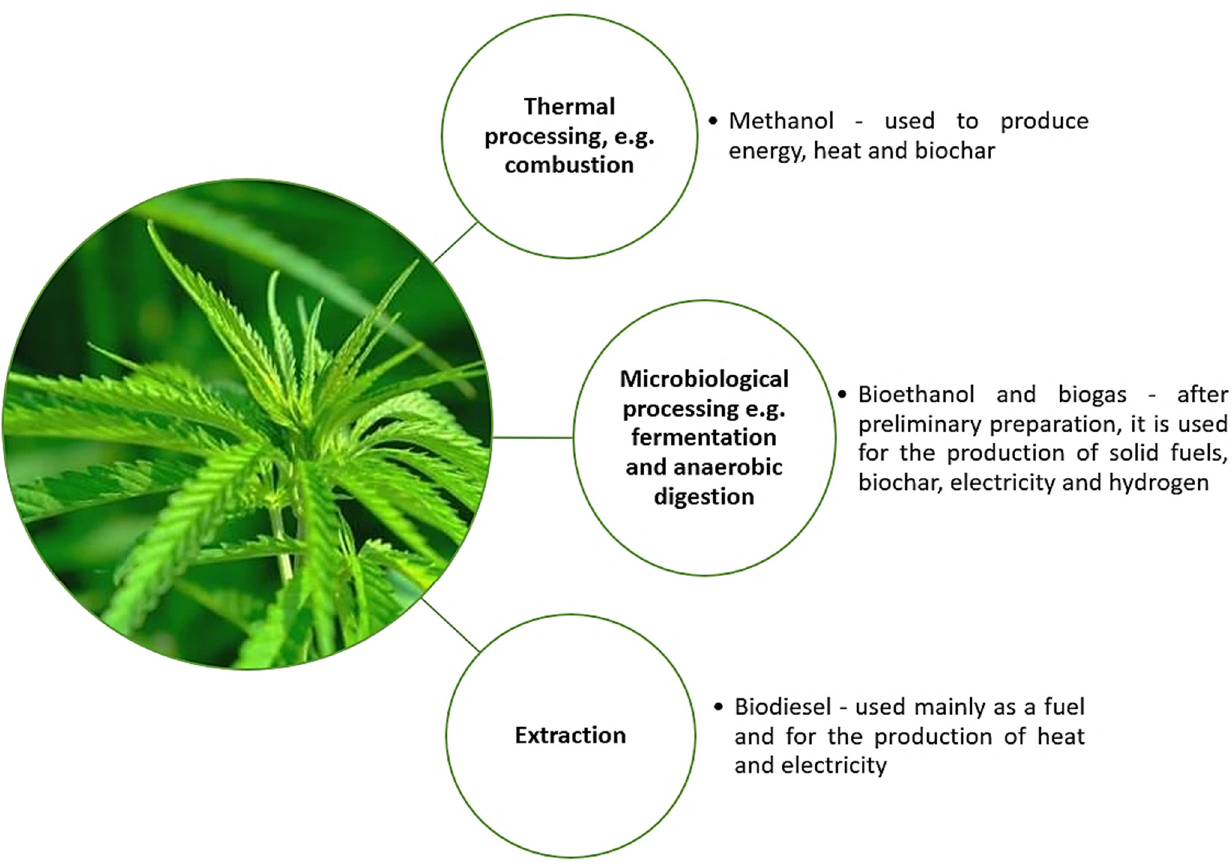
Figure 4. Processing cannabis for energy